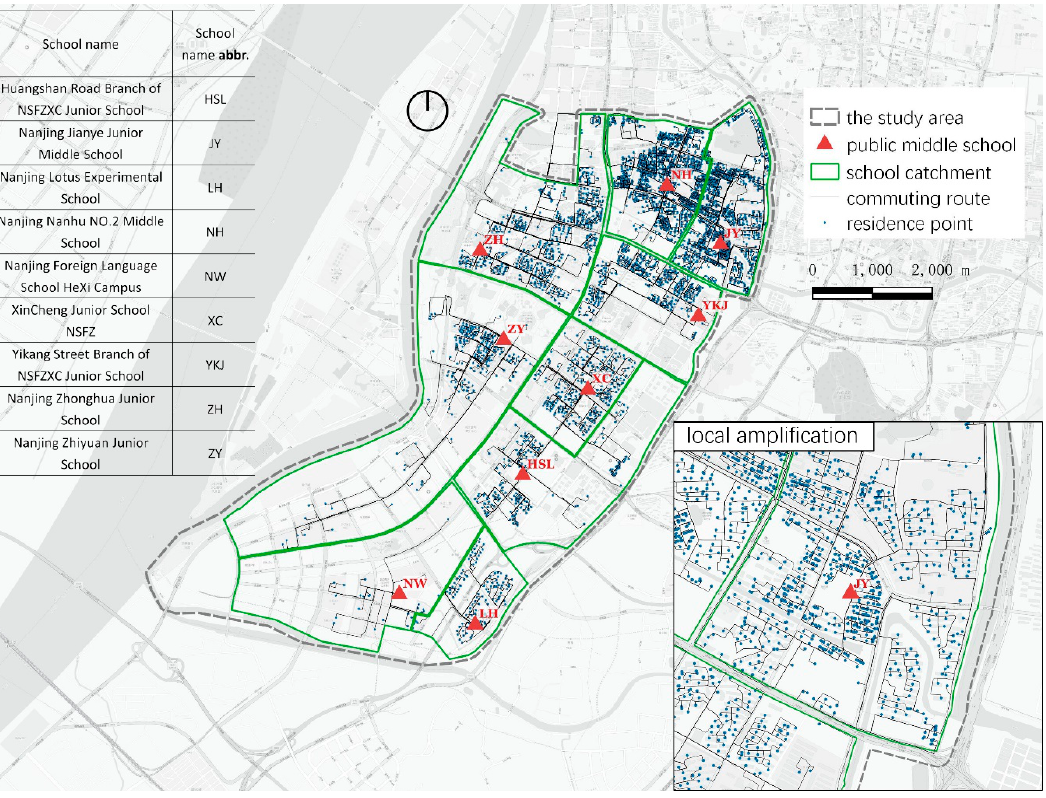
Figure 1. The study area showing residence distribution, school locations and catchment areas.